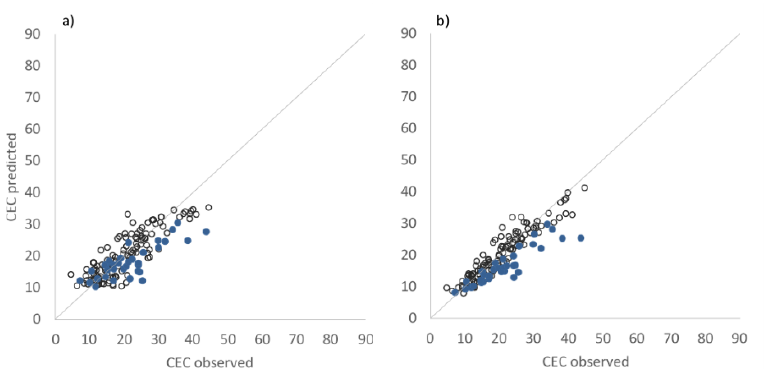
Fig. 3. Predicted cation exchange capacity (CEC, cmol(+) kg -1 ) in mineral soils modelled using a) clay (%) and b) clay and soil organic carbon (SOC, %) as predictors plotted against observed CEC (cmol(+) kg -1 ). Open circles represent the results of the calibration data and blue circles represent the validation data.